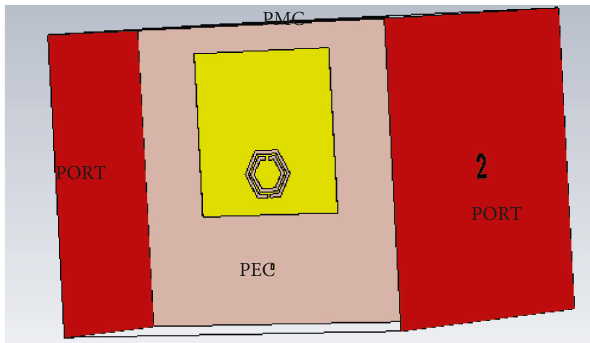
Figure 14: S parameter extraction setup.